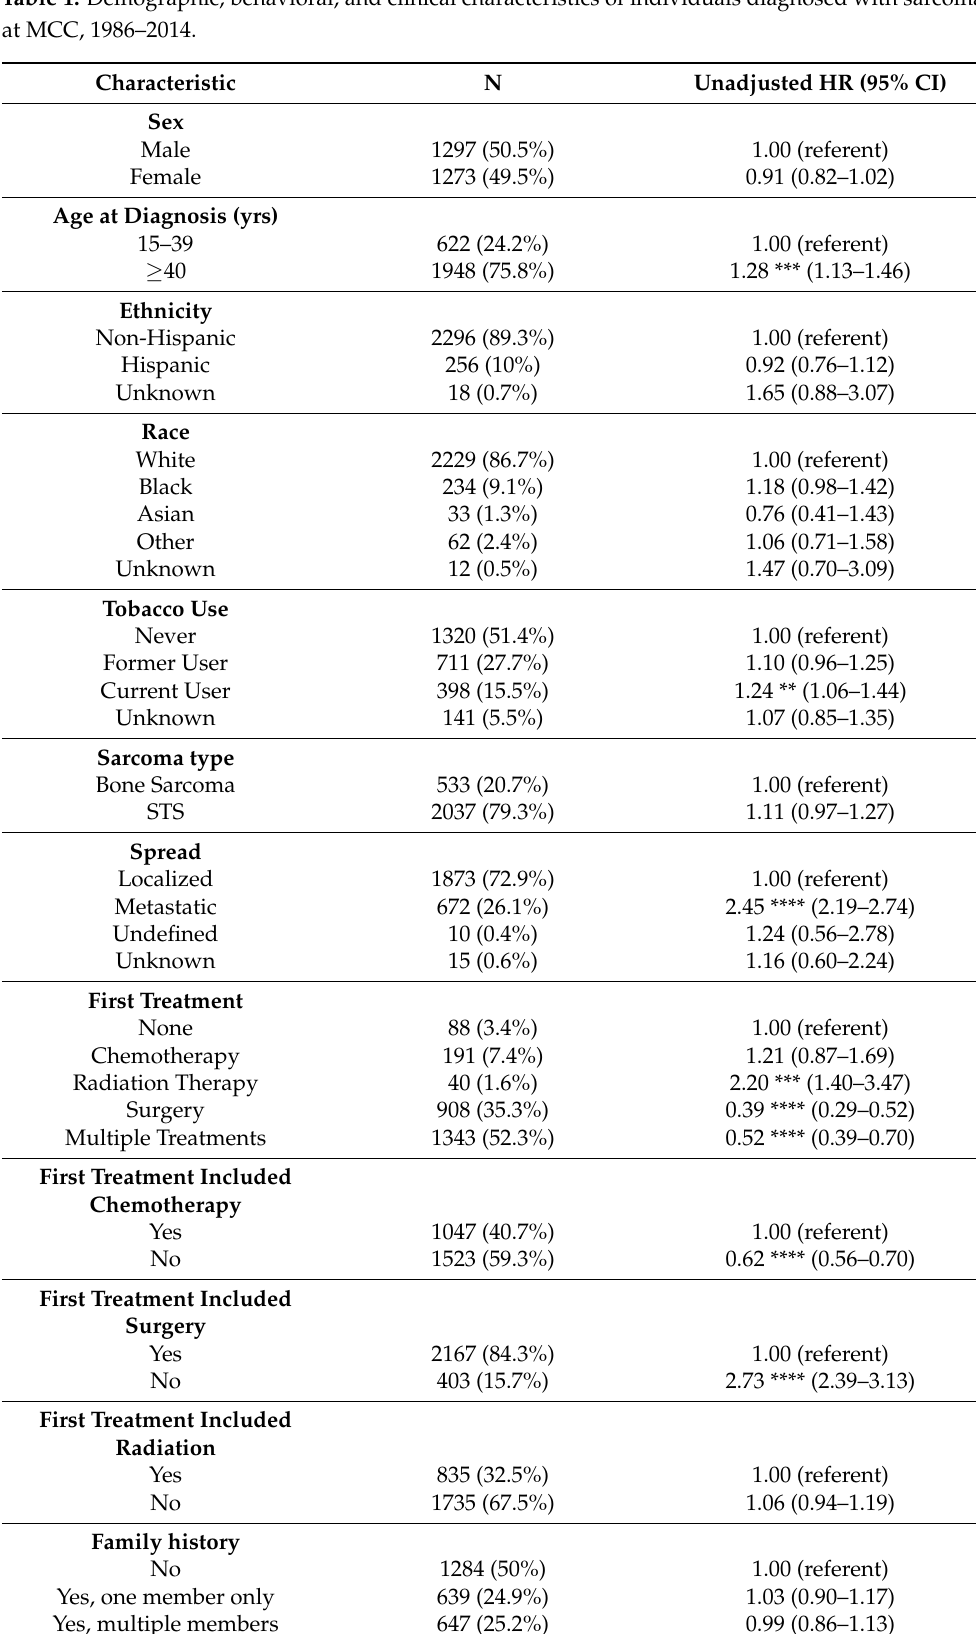
Table 1. Demographic, behavioral, and clinical characteristics of individuals diagnosed with sarcoma at MCC,